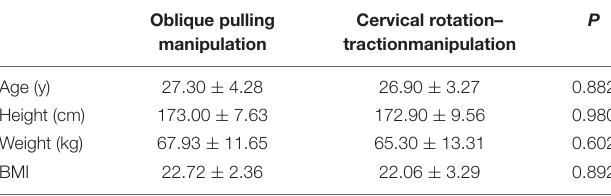
TABLE 1 | Comparison of baseline information between the two